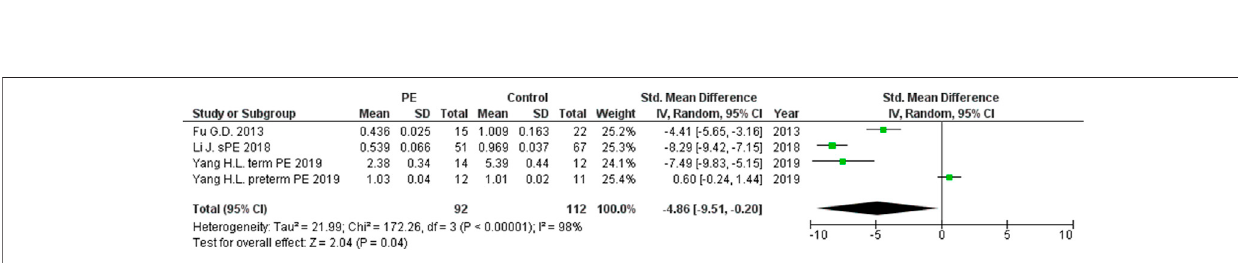
FIGURE 8 | Meta-analysis of differences in expression level of miRNA-376c in placenta between women with vs. without preeclampsia.